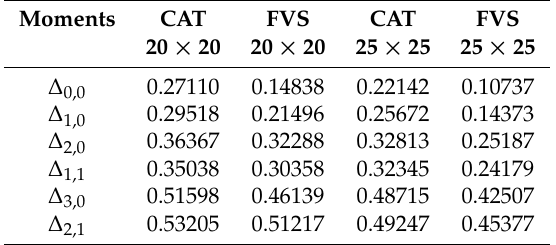
Table 3. Quantitative weighted sectional errors for constant kernel.